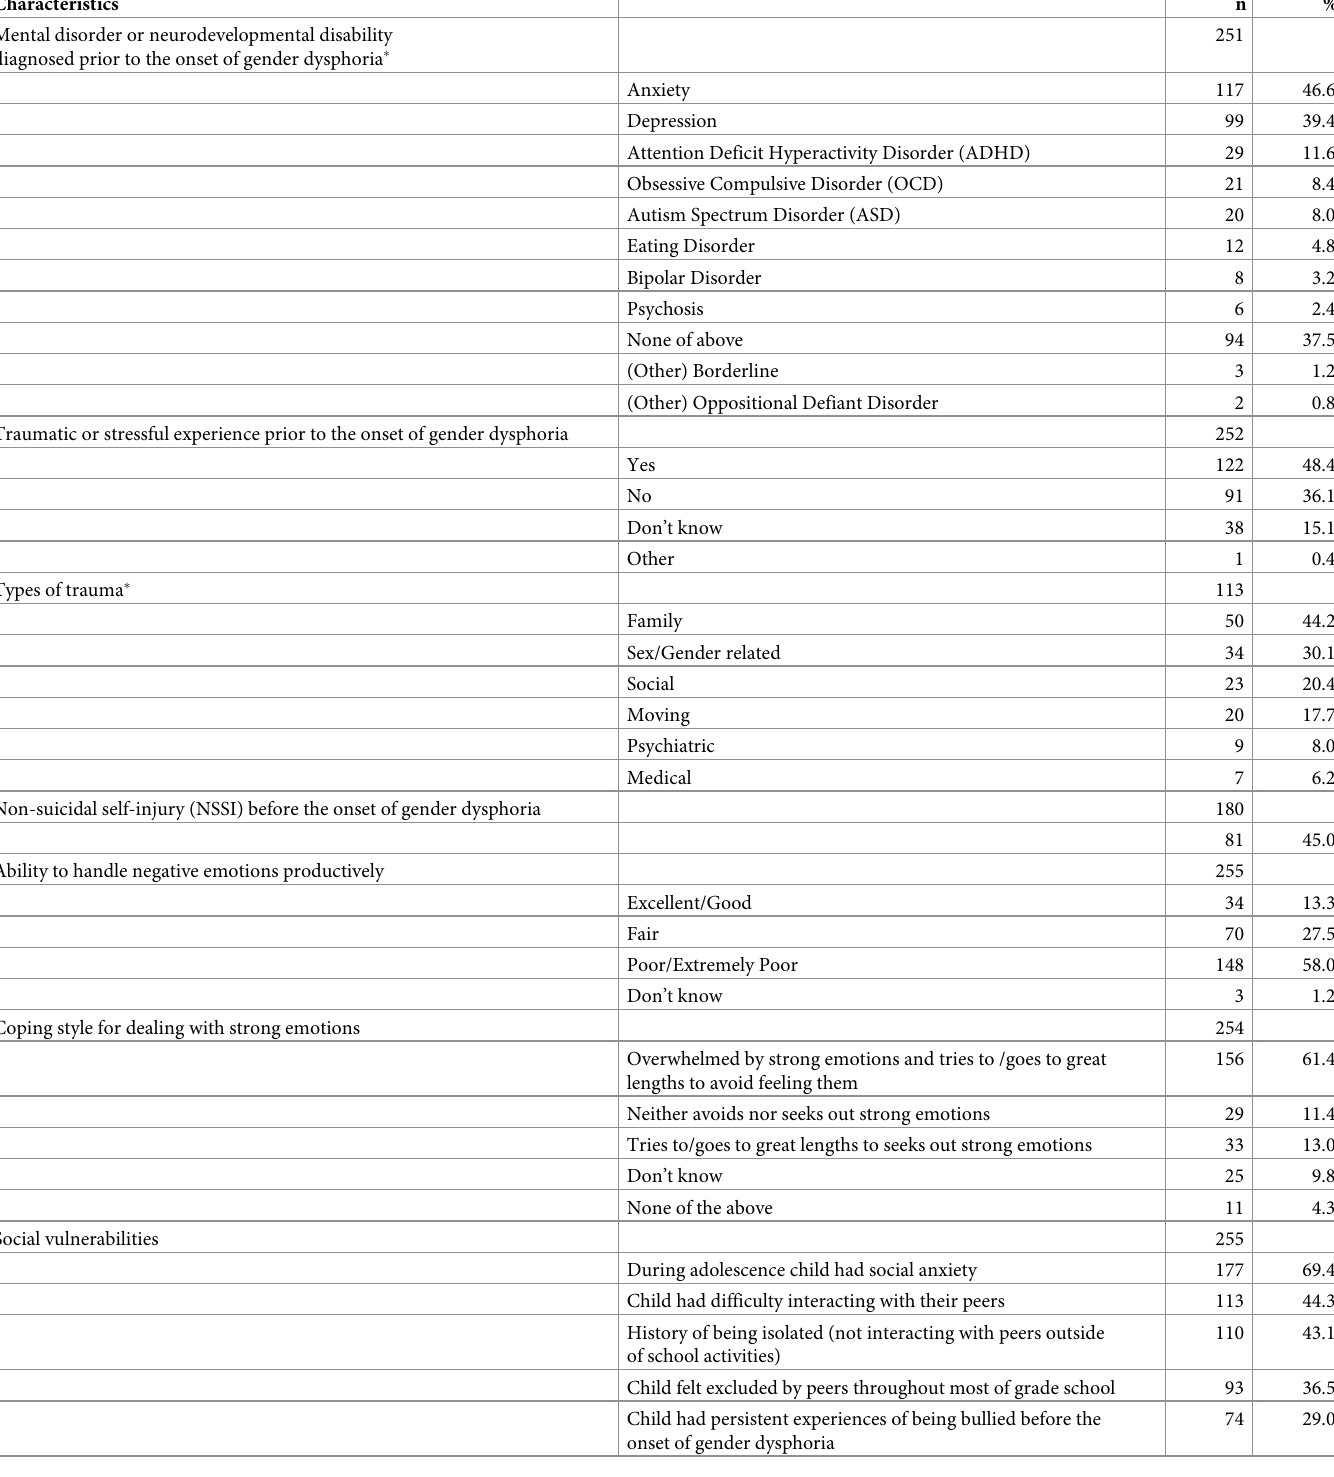
Table 4. AYA baseline comorbidities and vulnerabilities predating the onset of gender dysphoria.